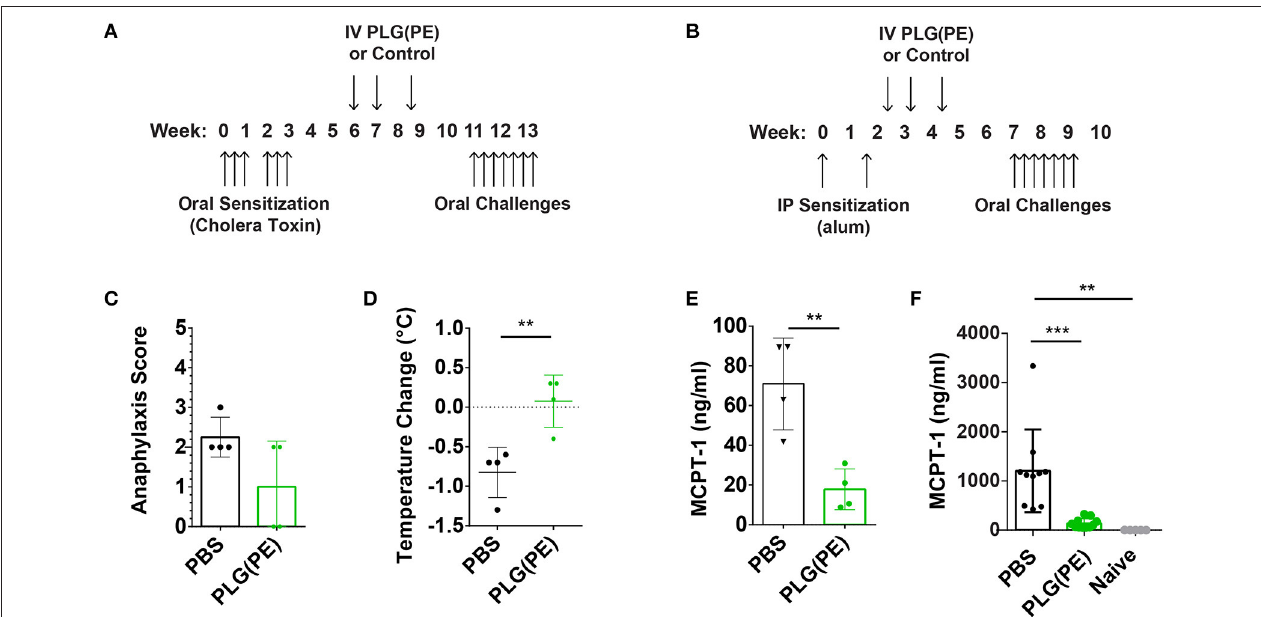
FIGURE 5 | Therapeutic efficacy of PLG(PE) in multiple murine models of peanut allergy. Mice were sensitized with cholera toxin ( n = 4 per group) beginning on Day 0, were treated with PLG(PE) on days 42, 49, and 59, and received intragastric challenge over days 77 through 91 (A) . Symptoms of anaphylaxis and body temperature were recorded every 15min for at least 1h after the 7th challenge, and data represent the maximum change in temperature. PLG(PE) trended toward protection against anaphylactic symptoms (C) and significantly reduced the degree of temperature drop (D) as well as serum MCPT-1 (E) . Results were confirmed by measuring serum MCPT-1 in alum-sensitization. (B) Mice were sensitized with alum on Days 0 and 14, treated with PLG(PE) on Days 21, 28, and 38, and received intragastric challenges over days 49 through 63. PLG(PE) provided protection from serum MCPT-1 release, indicating clinical protection from anaphylaxis (F) . Plots display mean